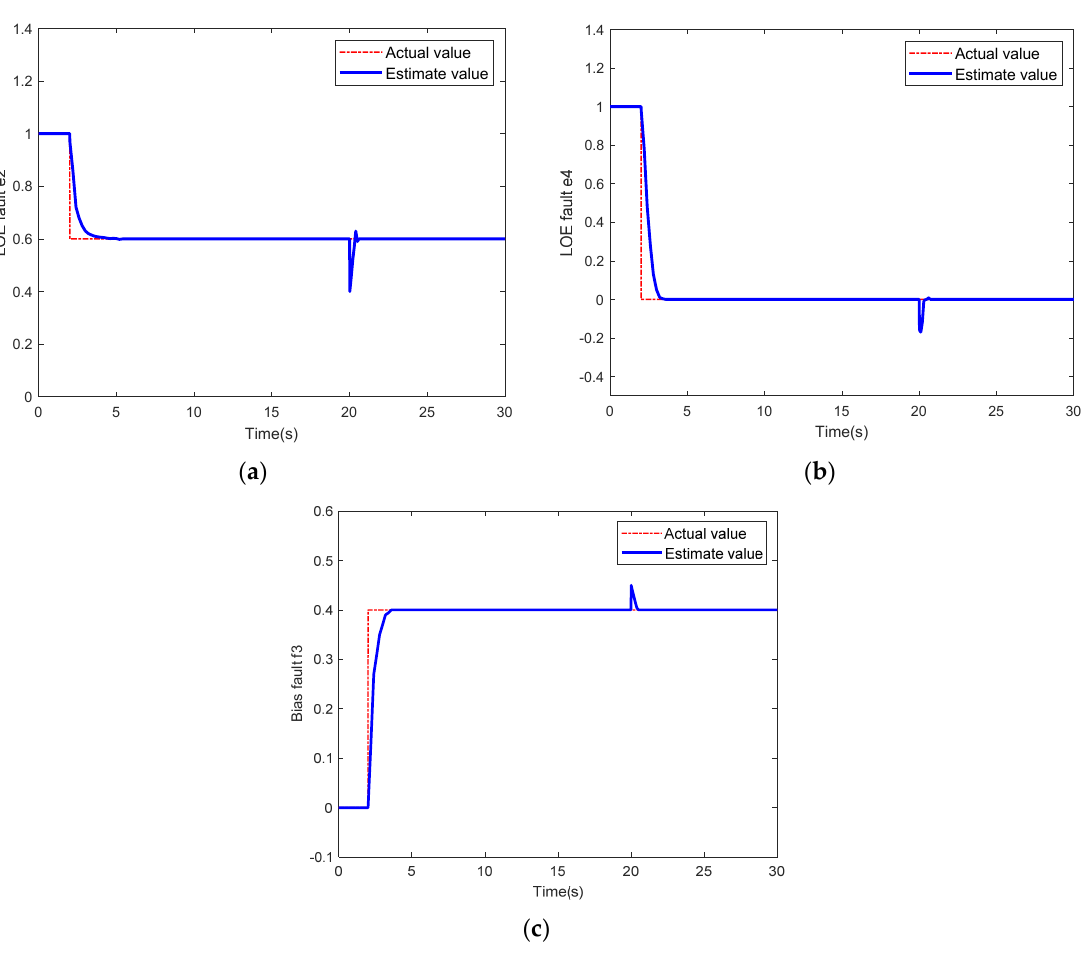
Figure 3. The actuator fault estimation results. ( a ) Estimation results of LOE fault e 2 . ( b ) Estimation results of LOE fault e 4 . ( c ) Estimation results of bias fault f 3 .